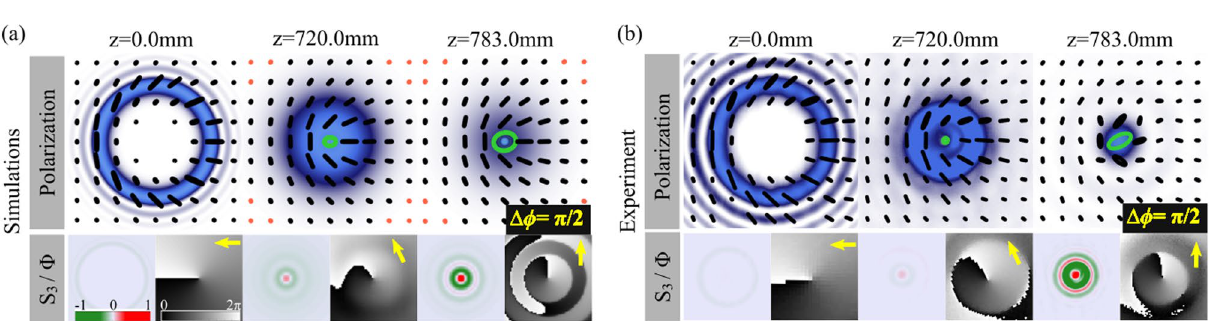
Figure 2. ( a ) Simulations and ( b ) experimental propagation dynamics of (cid:31) 1, − 1 modes. Top to bottom: intensity overlapped with polarization distribution and S 3 parameter (left) and the intermodal phase (cid:31) = S 1 + iS 2 (right). Such phase rotate an angle of �φ = 0 which is marked as yellow arrow.